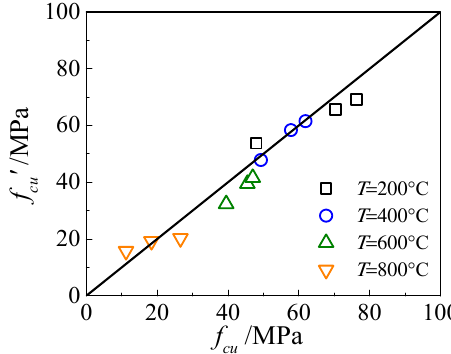
Figure 7. Comparison of test and calculation values.